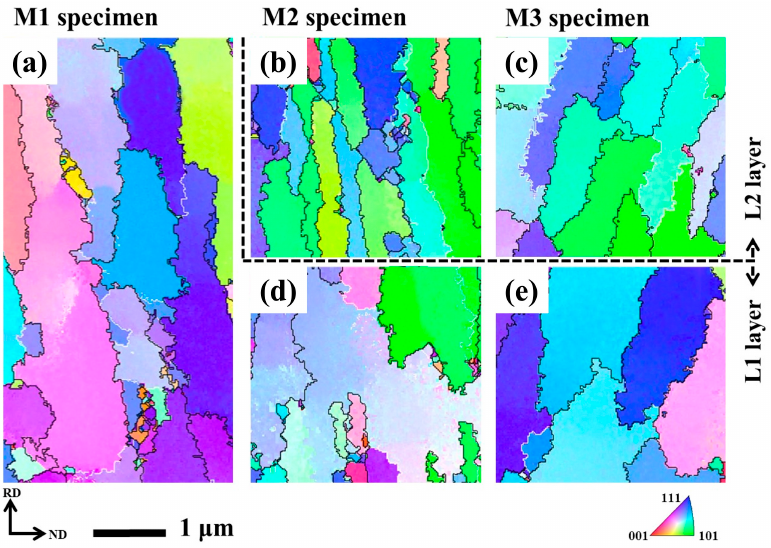
Figure 5. EBSD map of ( a ) M1, ( b , d ) M2 and ( c , e ) M3 sheets after three MARB cycles.